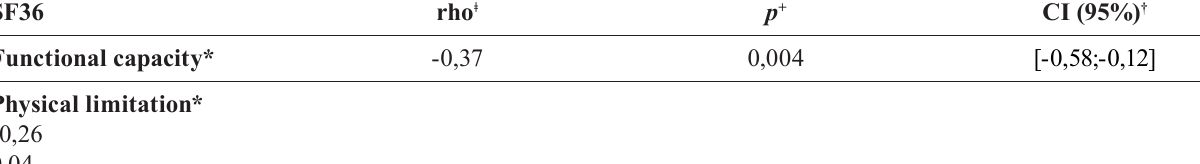
TABLE III - Correlation of DAS28 score with SF-36 domains